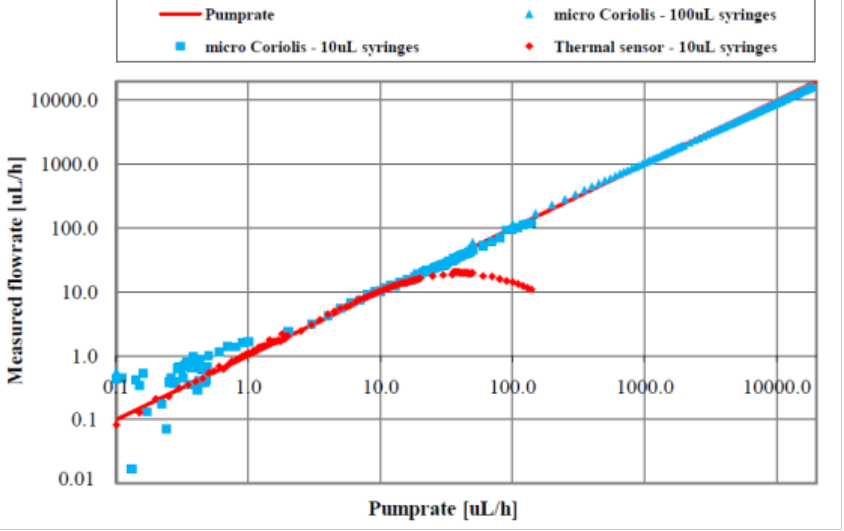
Figure 9. Measurement results demonstrating a dynamic range of more than five decades.